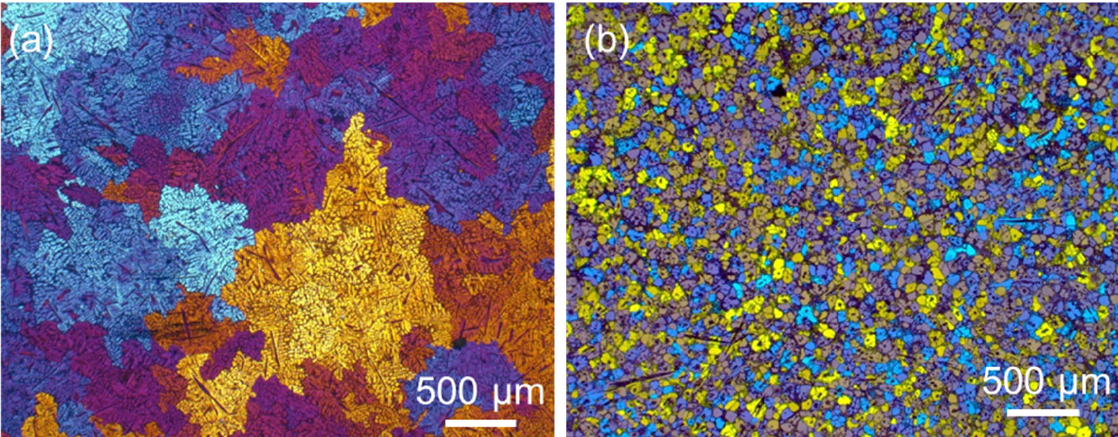
Figure 18. Grain refinement of α‐ Al grains in Al ‐ 4Fe alloy with 0.5 wt.% Zr addition: ( a ) optical micrographs of Al ‐ 4Fe solidified at 3.5 K/s; and ( b ) optical micrograph of Al ‐ 4Fe ‐ 0.5Zr solidified at 3.5 K/s showing the refinement of α‐ Al grains with the Zr addition. [102].